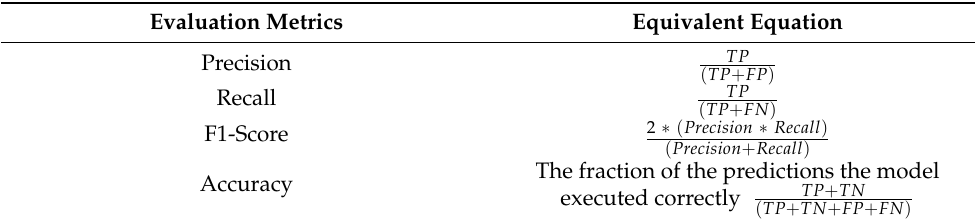
Table 1. The METRICS FOR THE MODELS comparison.